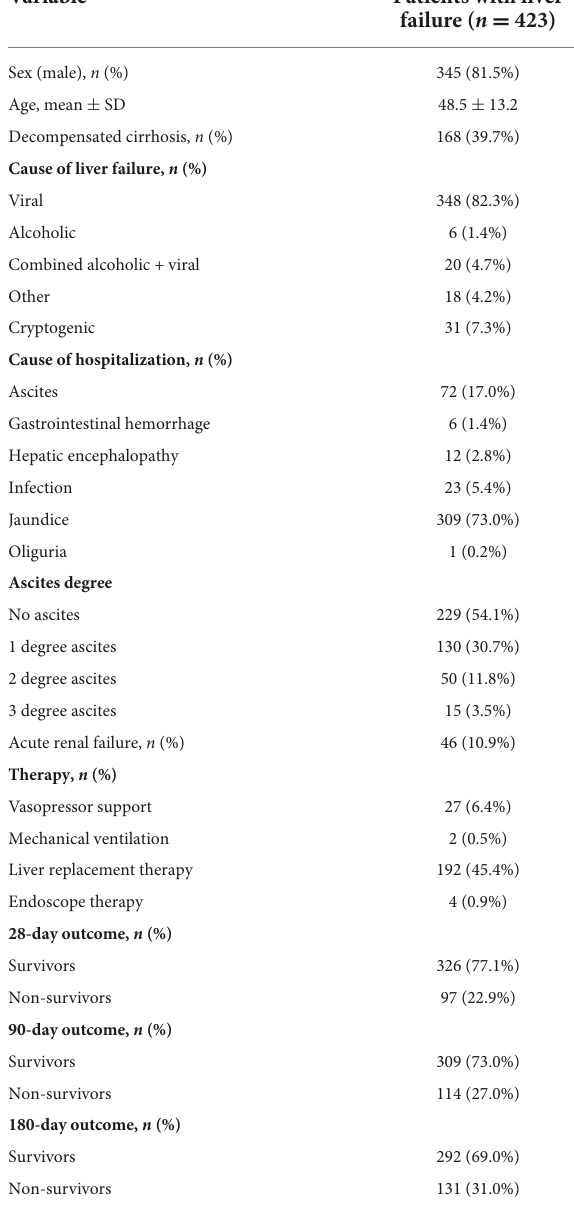
TABLE 1 Baseline characteristics of patients with